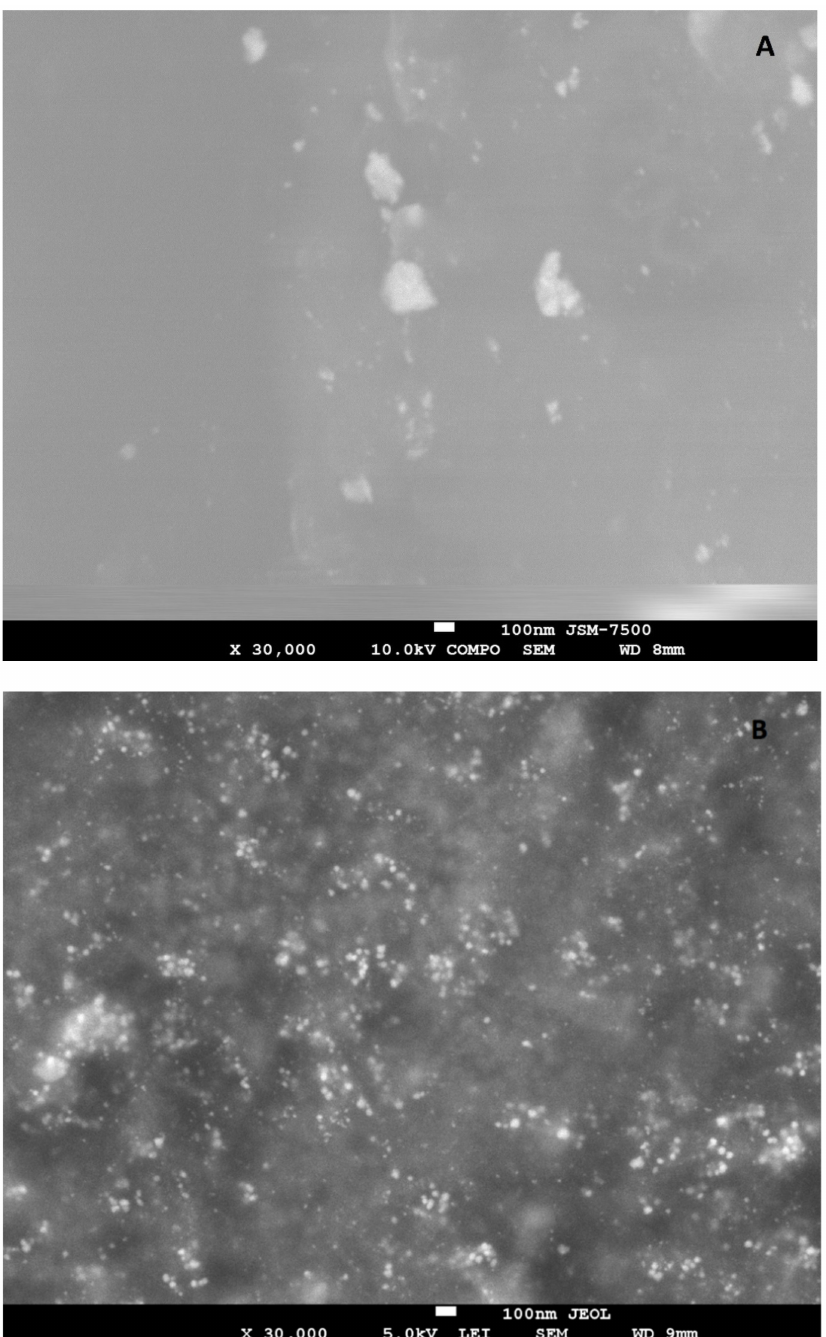
Figure 6. SEM photographs of silver nanoparticles on the surface of the perlon suture material: ( A ) before cyclic freezing/thawing; ( B ) after 10-fold cyclic